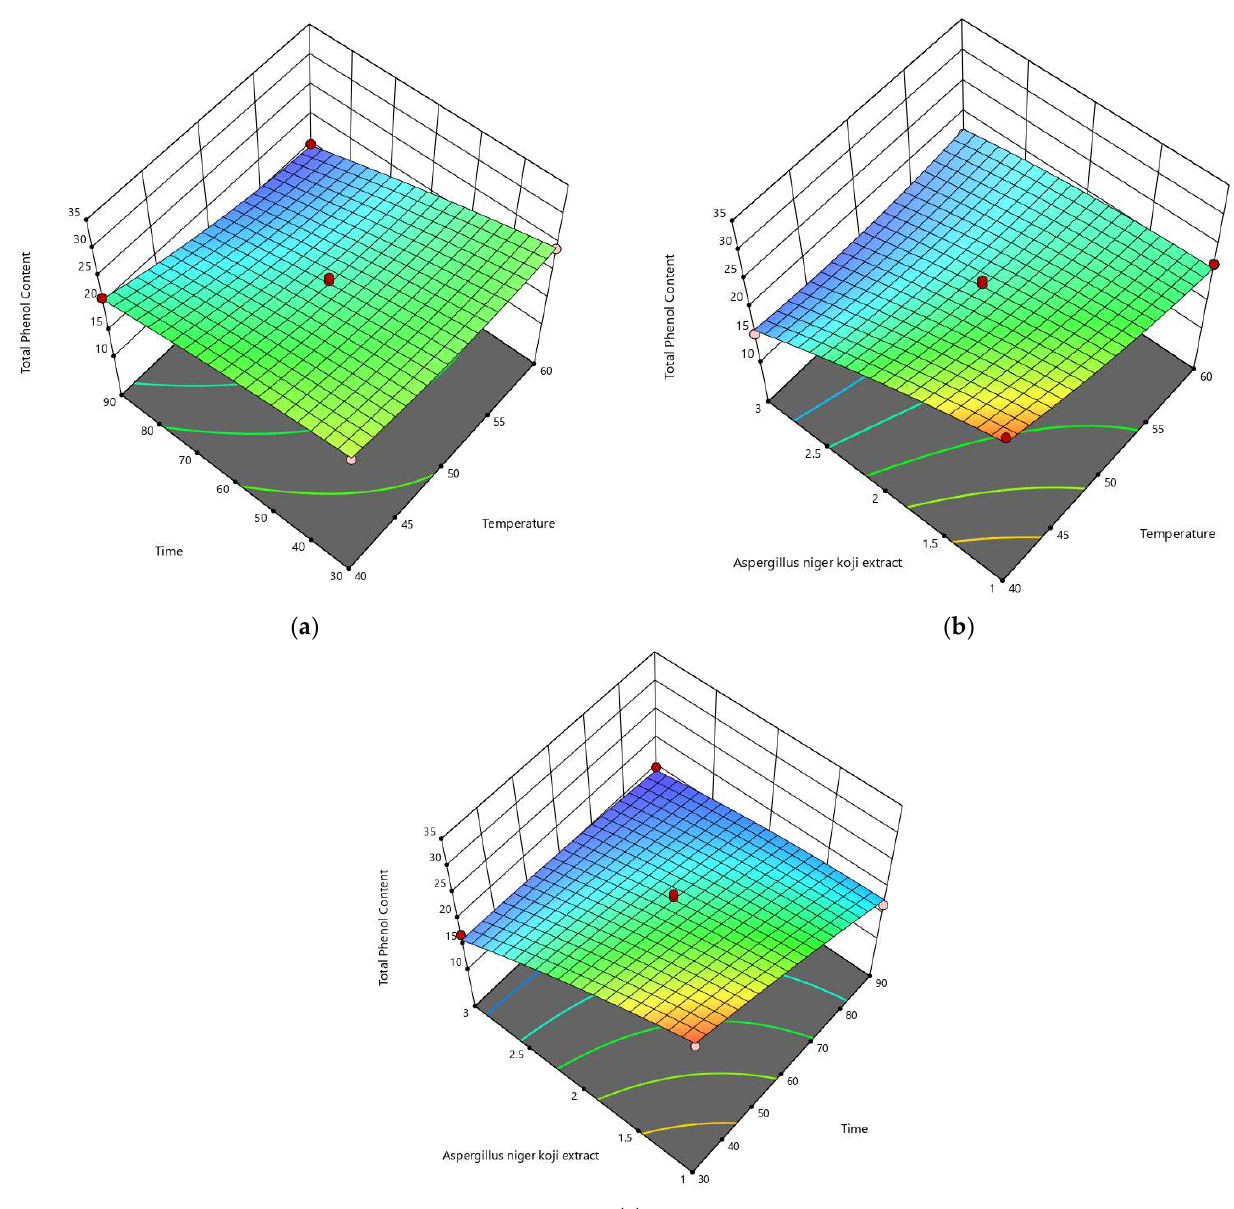
Figure 3. 3Three-dimensional response surface plots for TPC as affected by processing parameters ( a – c